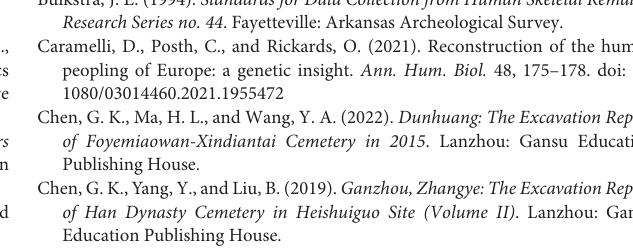
Supplementary Figure 1 | Pattern of DNA degradation. Supplementary Figure 2 | Phylogenetic relationship of Y-chromosome haplogroups in this study and their frequencies in Cao-Wei and Western Jin, Sixteen Kingdoms, Sui and Tang Dynasties, Undetermined. Supplementary Figure 3 | Phylogenetic relationship of mtDNA haplogroups in this study and their frequencies in Cao-Wei and Western Jin, Sixteen Kingdoms, Sui and Tang Dynasties, Undetermined. Supplementary Figure 4 | PCA plot based on mtDNA haplogroups frequency of Foyemiaowan populations and ancient reference populations. Supplementary Figure 5 | Bayesian maximum clade credibility (MCC) tree of complete mtDNA sequences belonging to haplogroup A6. Supplementary Figure 6 | Bayesian maximum clade credibility (MCC) tree of complete mtDNA sequences belonging to haplogroup D4. Supplementary Figure 7 | Bayesian maximum clade credibility (MCC) tree of complete mtDNA sequences belonging to haplogroup D4b2b. Supplementary Figure 8 | Bayesian maximum clade credibility (MCC) tree of complete mtDNA sequences belonging to haplogroup D4h1c. Supplementary Figure 9 | Bayesian maximum clade credibility (MCC) tree of complete mtDNA sequences belonging to haplogroup D4o. Supplementary Figure 10 | Bayesian maximum clade credibility (MCC) tree of complete mtDNA sequences belonging to haplogroup F1a1c. Supplementary Figure 11 | Bayesian maximum clade credibility (MCC) tree of complete mtDNA sequences belonging to haplogroup F2a. Supplementary Figure 12 | Bayesian maximum clade credibility (MCC) tree of complete mtDNA sequences belonging to haplogroup G1a2’3. Supplementary Figure 13 | Bayesian maximum clade credibility (MCC) tree of complete mtDNA sequences belonging to haplogroup H7b. Supplementary Figure 14 | Bayesian maximum clade credibility (MCC) tree of complete mtDNA sequences belonging to haplogroup J1b1a1 + 146. Supplementary Figure 15 | Bayesian maximum clade credibility (MCC) tree of complete mtDNA sequences belonging to haplogroup M9a1a. Supplementary Figure 16 | Bayesian maximum clade credibility (MCC) tree of complete mtDNA sequences belonging to haplogroup Z3. Supplementary Figure 17 | Bayesian maximum clade credibility (MCC) tree of complete mtDNA sequences belonging to haplogroup Z3 + 709. Supplementary Figure 18 | (A) Xincheng cemetery (Wei to Jin Dynasties), Burial 6, showing two people picking mulberry (E et al., 2009a). (B) Xigou cemetery (Wei to Jin Dynasties), containing two individuals, a male was riding a horse on the left side, a woman with long hair standing on his right side (Ma, 2000). (C) Xincheng mural tomb (Wei to Jin Dynasties), Burial 3, depicts two people living inside the yurt, one sleeping, the other cooking (Gansu Province Cultural Relics Team, and Gansu Province Museum, 1985). (D) Dingjiazha cemetery (Sixteen Kingdoms), Burial5, showing a man plowing (E et al.,